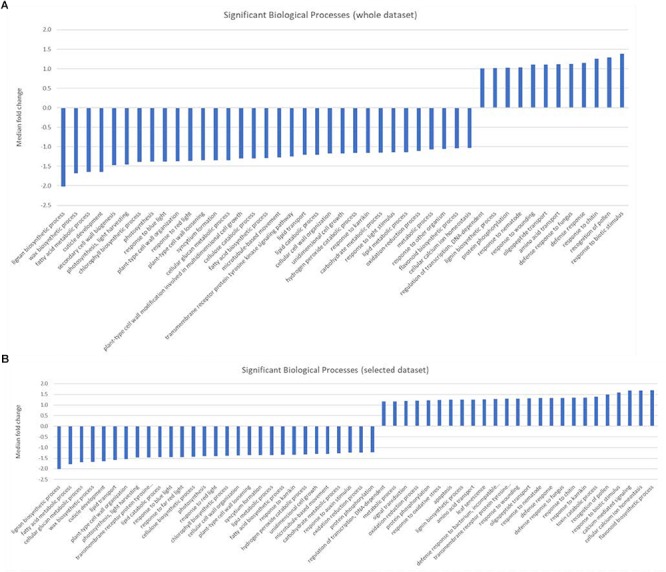
(A,B) Graphic showing the median fold change of genes associated with significantly over-represented biological processes identified from (A) either the entire dataset, or (B) selected genes that were preferentially expressed in either the central population relative to the northern population (positive values) or genes that were preferentially expressed in the northern population (negative values).